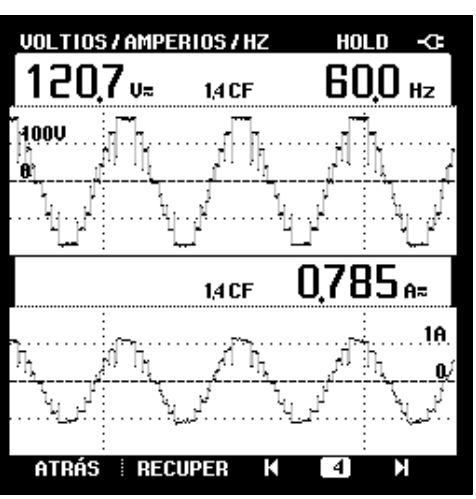
Figure 12: Waveforms Obtained by Fluke 43B Analyzer with Multilevel Inverter and Resistive Load. Source: Authors, (2021).